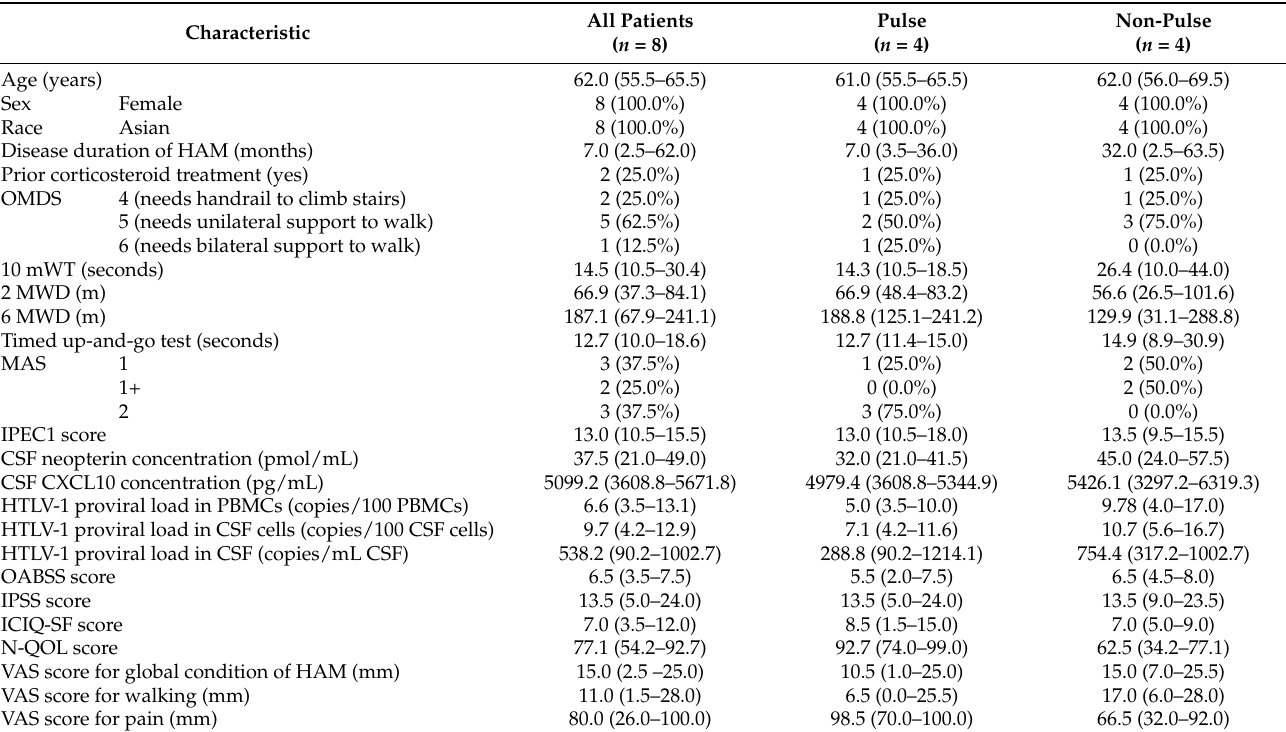
Table 1. Characteristics of rapid progressors at